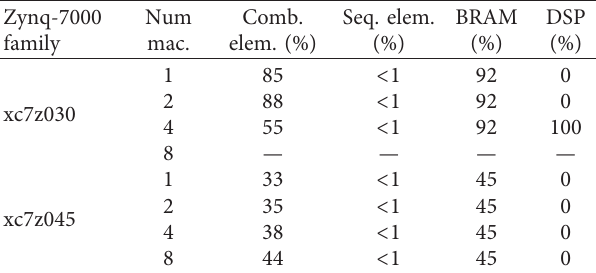
Table 8: Design portability analysis for Zynq-7000 family. Zynq-7000